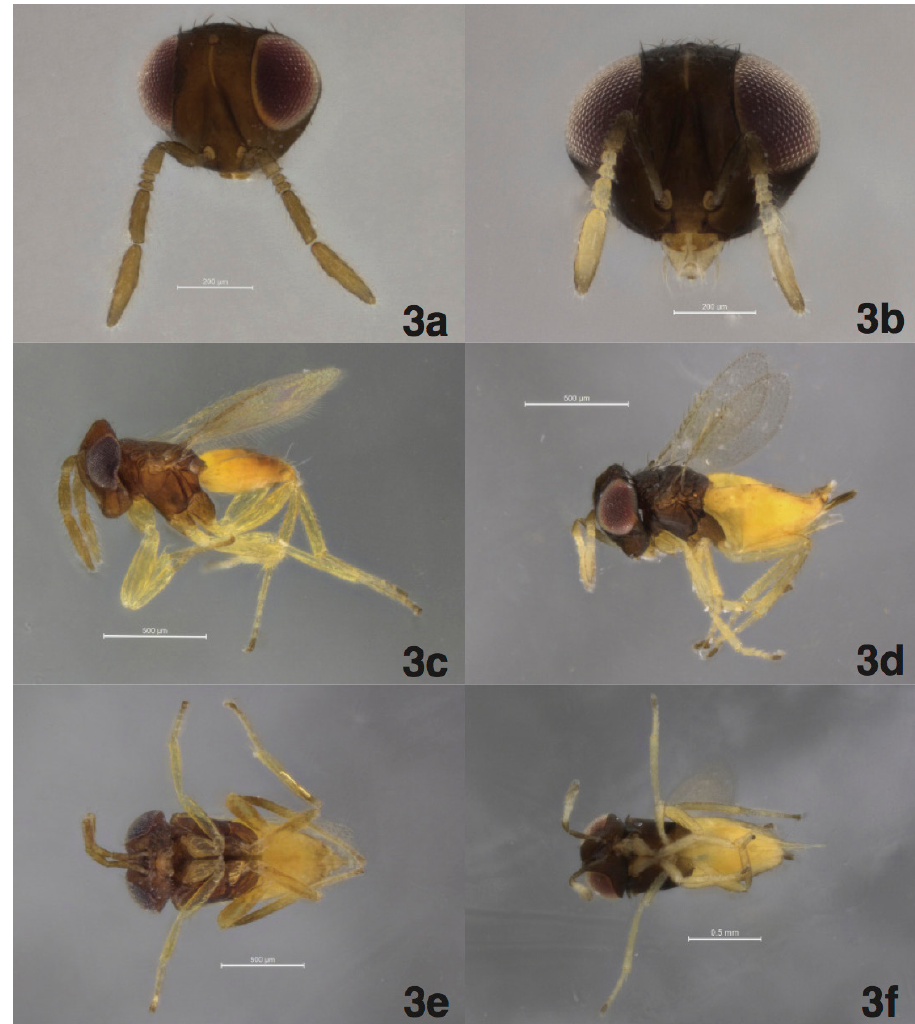
Figure 3. Aphelinus asychis , card-mounted specimens 3a male, antennae and head, lateral view (BMNH 1038770) 3b female, antennae and face, anterior view (BMNH 1038772) 3c male, habitus, lateral view (BMNH 1038770) 3d female, habitus, lateral view (BMNH 1038772) 3e male, habitus, dorsal view (BMNH 1038770) 3f female, habitus, dorsal view (BMNH 1038772).